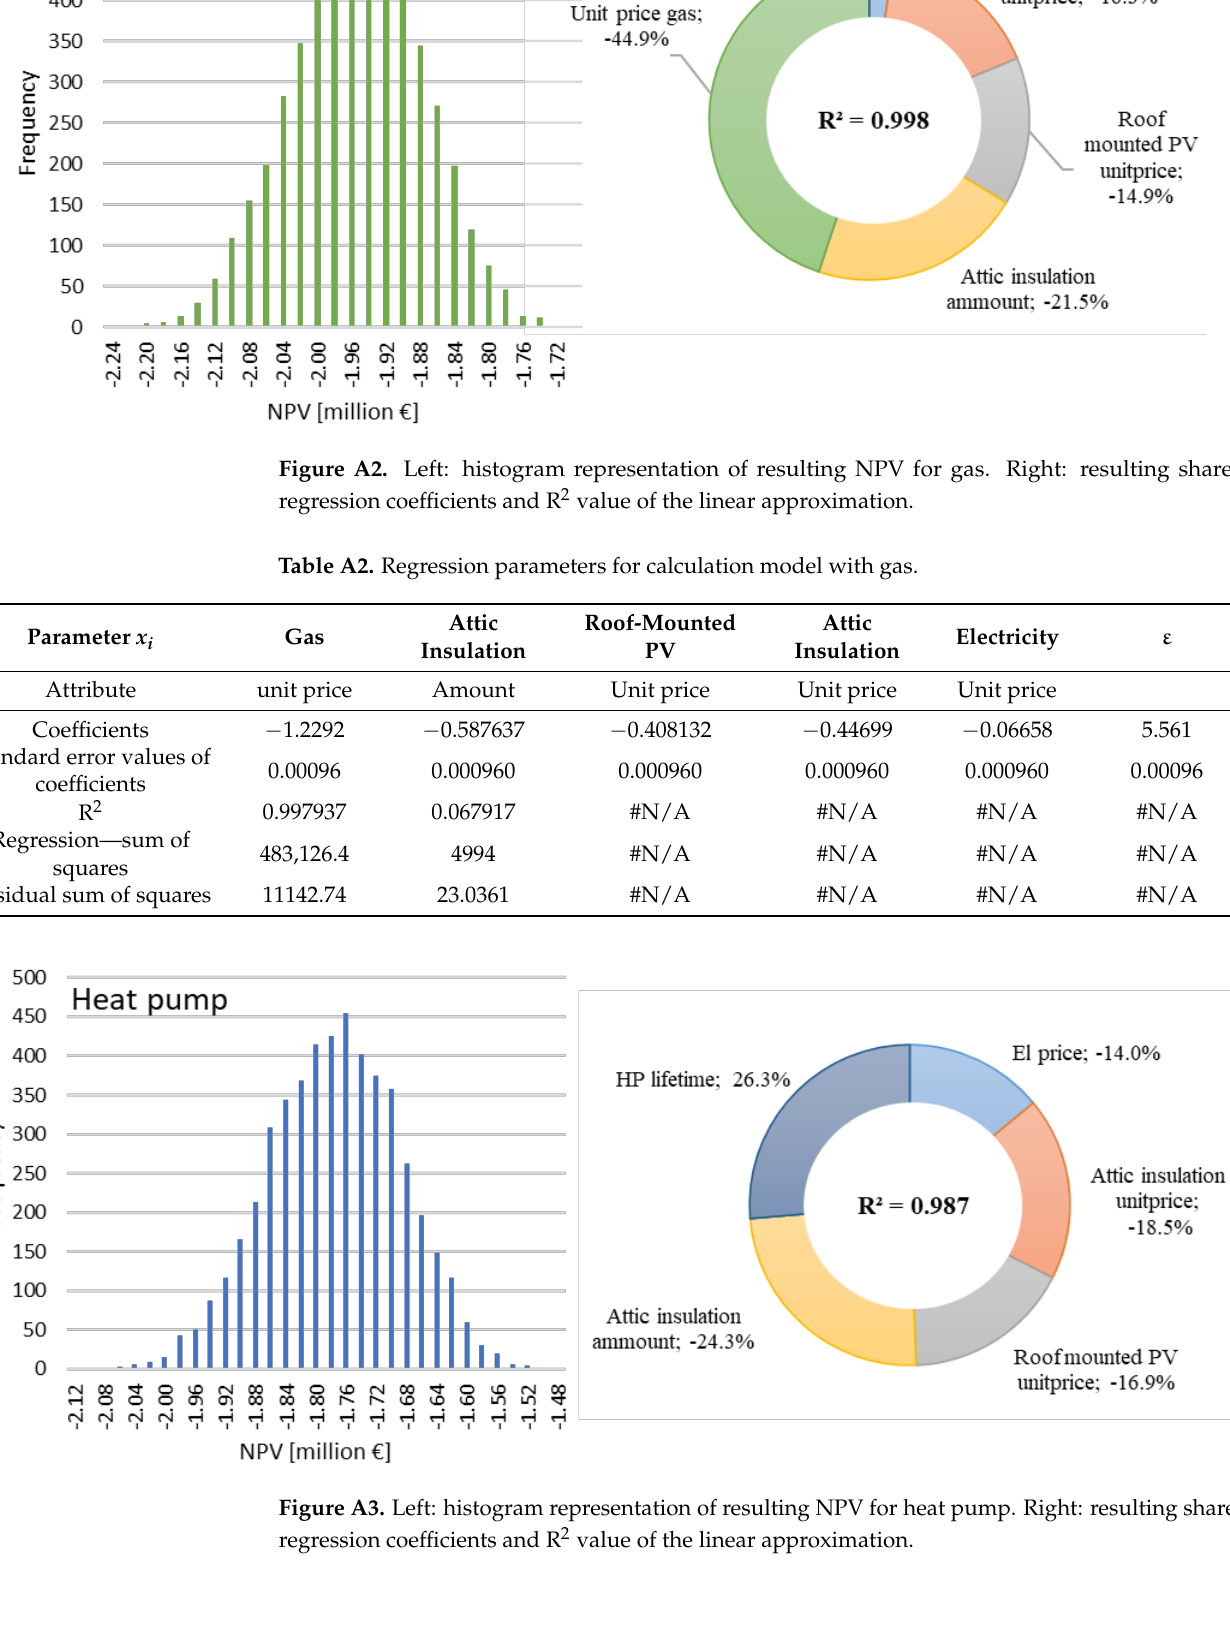
25 of 28 Appendix A Figure A1. Left: histogram representation of resulting NPV for low district heating unit cost. Right: resulting share of regression coefficients and R 2 value of the linear approximation. Table A1. Regression parameters for calculation model with District Heating. Regressions for all three cost levels of DH are identical. Parameter x i